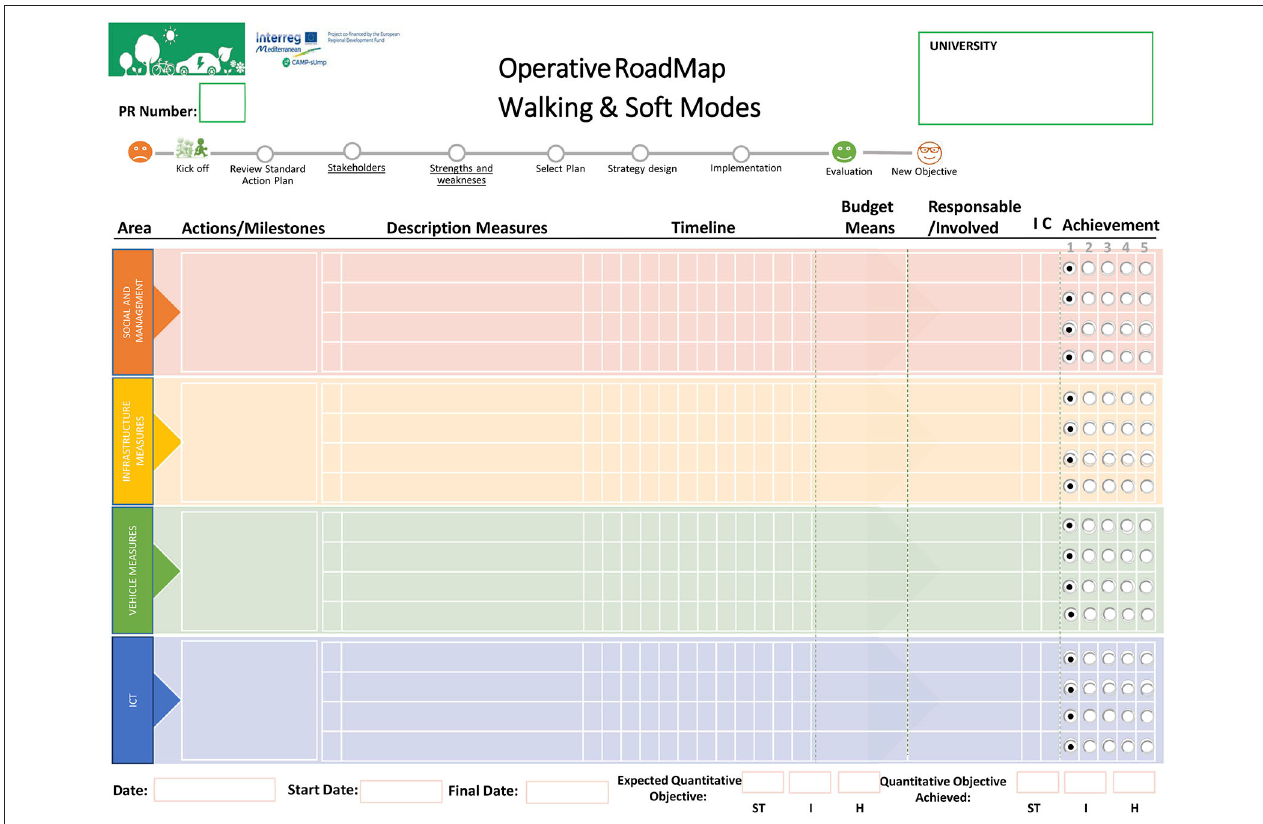
FIGURE 3 | Template of an operational roadmap for the strategic line of walking (Extracted from Deliverable 3.5.1 CAMP-sUmp Project, Tormo Lancero et al.,